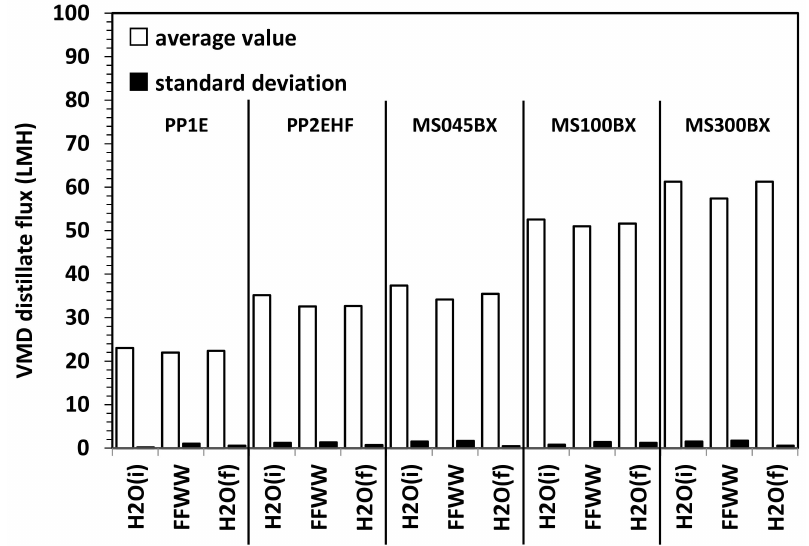
Figure 8. Average VMD distillate flux and SD for PP and PTFE MS membranes. Figure 9 refers to RO tests carried at different operating pressures. Average